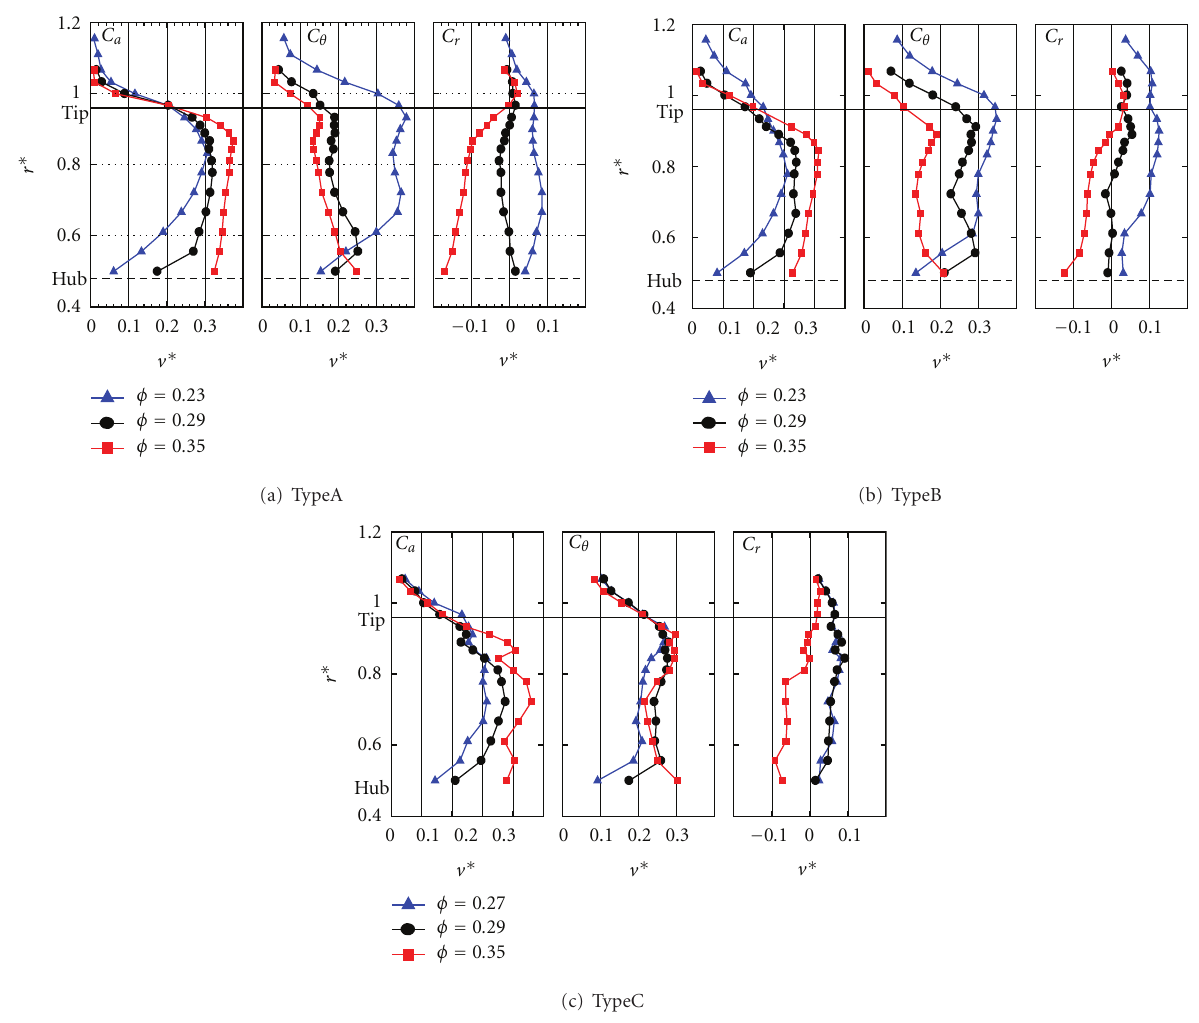
Figure 6: Distributions of time-mean velocity component along radius for three types of fan at rotor